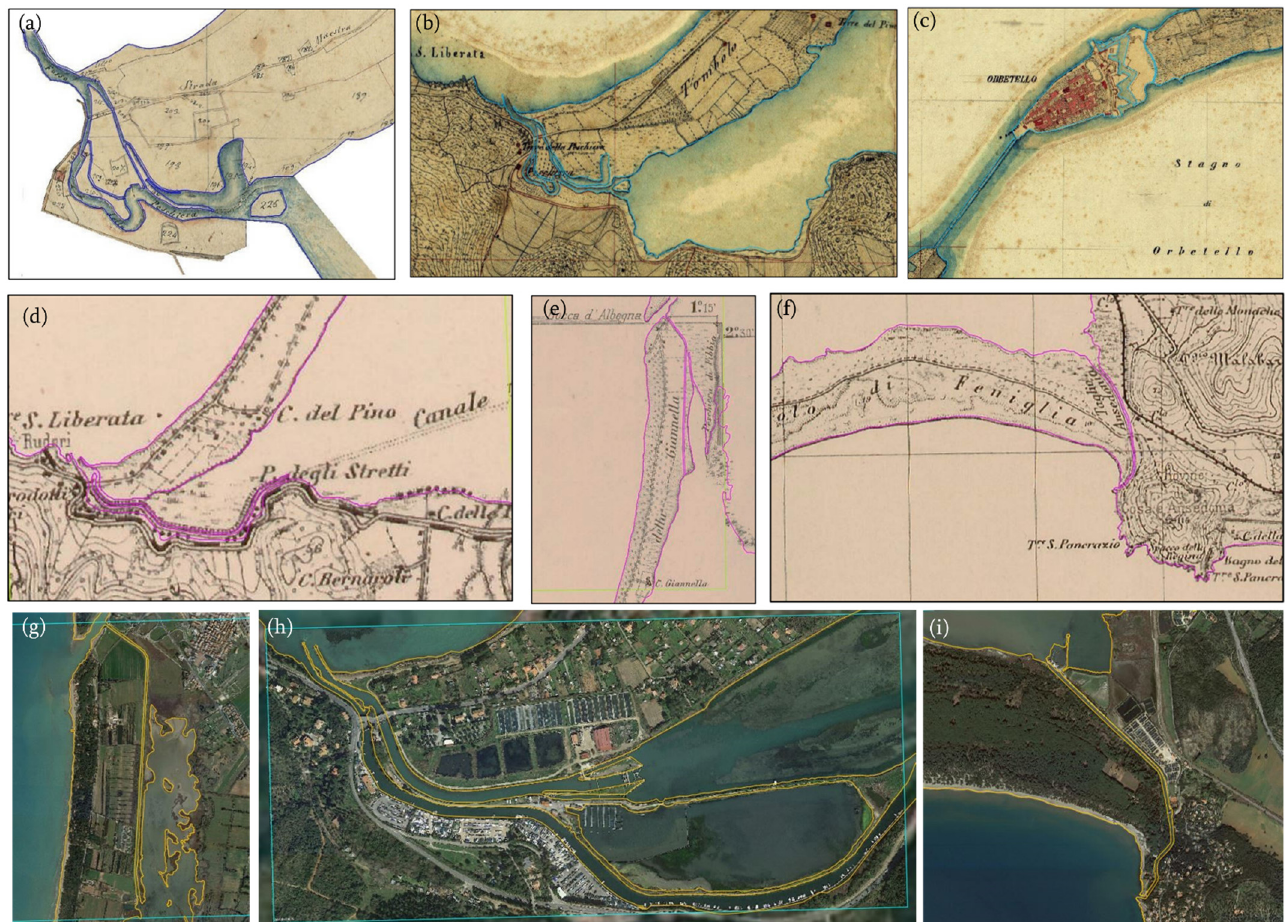
Figure 7. Detail of the Nassa and S. Liberata inlets in the 1824 ( a ) and 1862 ( b ) scenarios, based on cadastral maps; view of the Orbetello isthmus and Ponte Diga in the 1862 scenario ( c ); details of the Nassa, S. Liberata, Fibbia, and Ansedonia inlets in the 1907 scenarios ( d – f ); satellite image of the area around the Fibbia ( g ), Nassa ( h ) and Ansedonia ( i ) inlets in the present scenario, with the tourist harbor visible in the Santa Liberata inlet ( h ).